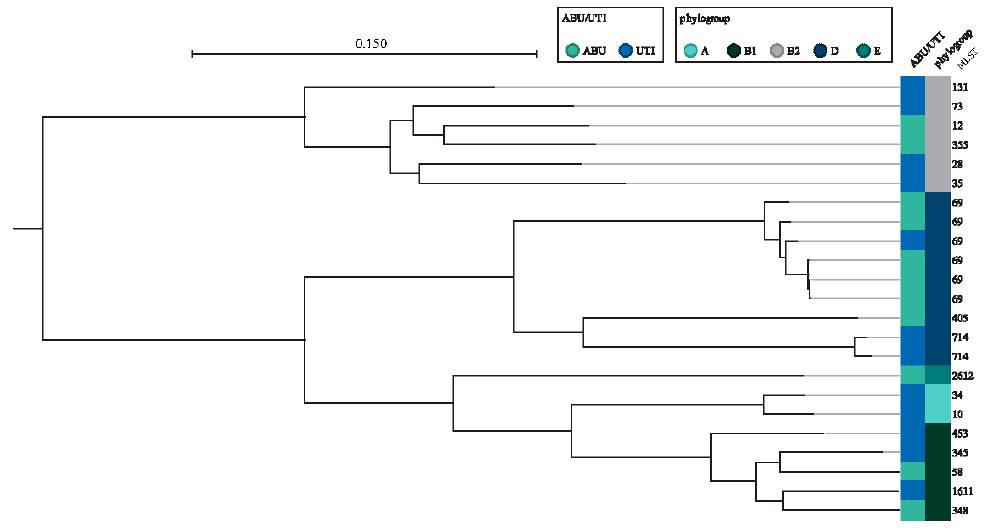
Figure 2. SNP phylogeny of E. coli isolates from asymptomatic bacteriuria (ABU) and urinary tract infections (UTI) based on whole-genome sequencing.